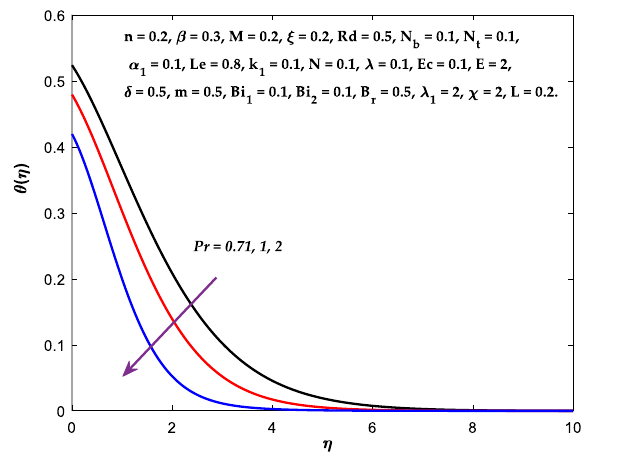
Figure 8. Diagram of Pr v/s θ(η) .